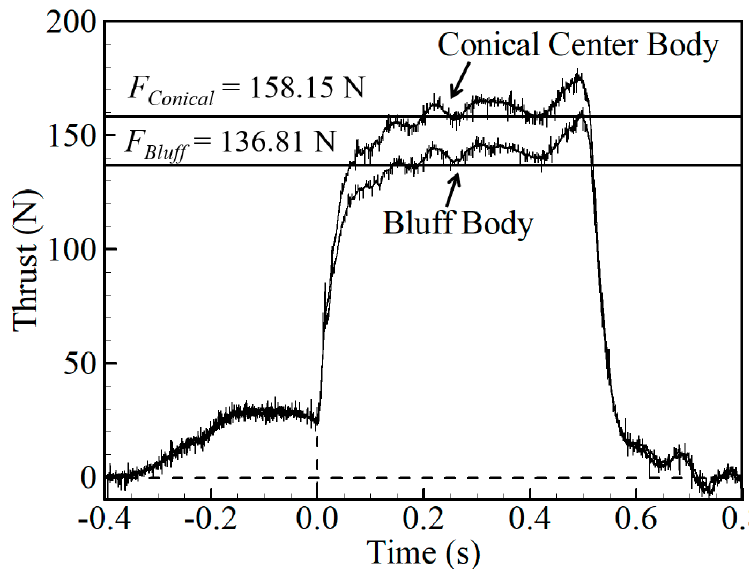
. m t = 160.9 ± 0.9 g/s, Φ = 0.471 ± 0.005. Figure 11. Thrust history at 𝑚(cid:4662) (cid:3047) = 160.9 ± 0.9 g/s, 𝛷 = 0.471 ± 0.005.